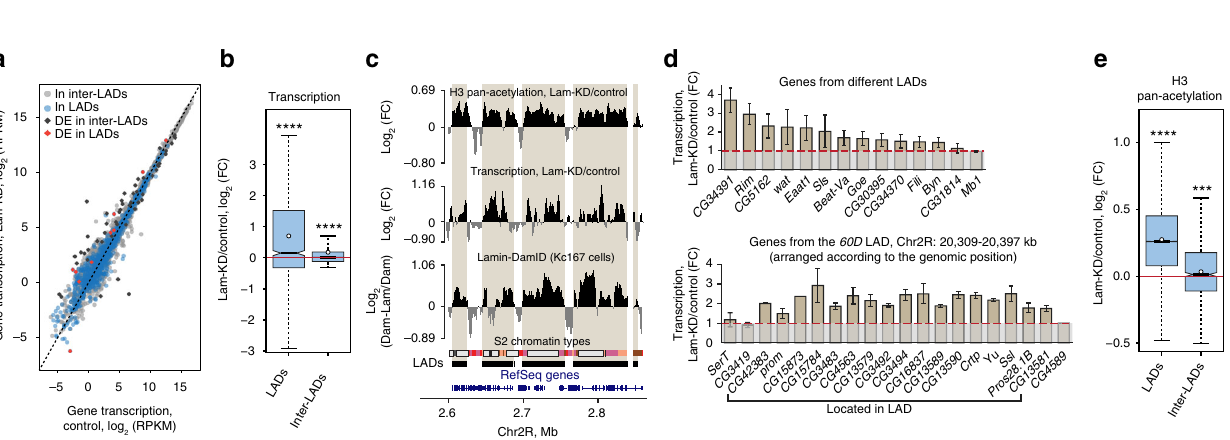
Fig. 2 Nuclear lamina disruption leads to the increased H3 pan-acetylation and transcriptional upregulation in LADs. a Gene expression in Lam-KD and control S2 cells according to the RNA-seq data. Genes located in LADs and inter-LADs are designated by light-blue and light-grey circles, respectively. Differentially expressed (DE) genes, located in LADs and inter-LADs, are designated by black and red rectangles, respectively. b Changes of total transcription according to the RNA-seq data between Lam-KD and control S2 cells in LADs and in inter-LADs. c A representative screenshot from UCSC Genome Browser showing the Lamin – DamID pro fi le in Kc167 cells 5 and log 2 (FC) pro fi les of H3 pan-acetylation (according to ChIP-seq) and transcription (according to RNA-seq) in Lam-KD/control S2 cells. Chromatin annotation in S2 cells 40 , LAD annotation in Kc167 cells 28 , and RefSeq gene positions are shown below. d Changes in the transcription level in Lam-KD compared to control S2 cells by RT-PCR analysis for the randomly chosen genes from different LADs (top panel), and for all the genes from the 60D LAD (bottom panel). In the bottom panel, genes SerT, CG3419 and CG4589 are located outside the LAD. Expression data of Crtp , Yu , Ssl , Pros28.1B and CG13581 genes upon Lam-KD in S2 cells are from ref. 11 . Error bars show SEM between two independent biological replicates. e Changes of H3 pan-acetylation according to ChIP-seq data between Lam-KD and control S2 cells in LADs and in inter- LADs. In panels ( b , e ), **** P < 0.0001, *** P < 0.001 in a Wilcoxon test. See Fig. 1g legend for description of boxplot